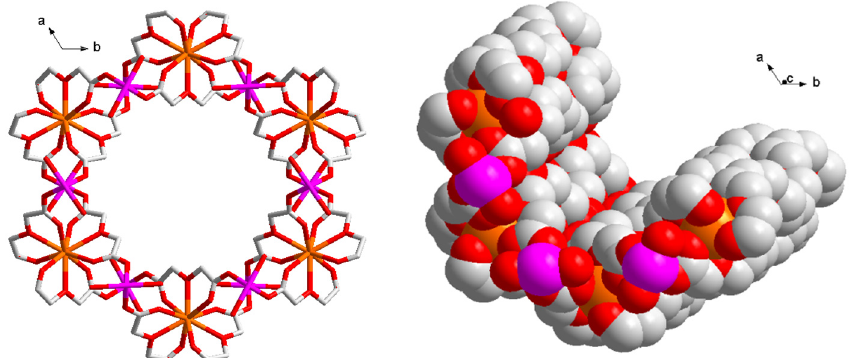
Figure 1. Left : partial view of complex ( 2 ) along the crystallographic c axis, showing the generated hexagonal channels. H atoms and crystallization water molecules are omitted for clarity. Right : cross-section of the channel showing the inner exposed surface. Color code: La, orange; Co, pink; O, red; C, light grey.